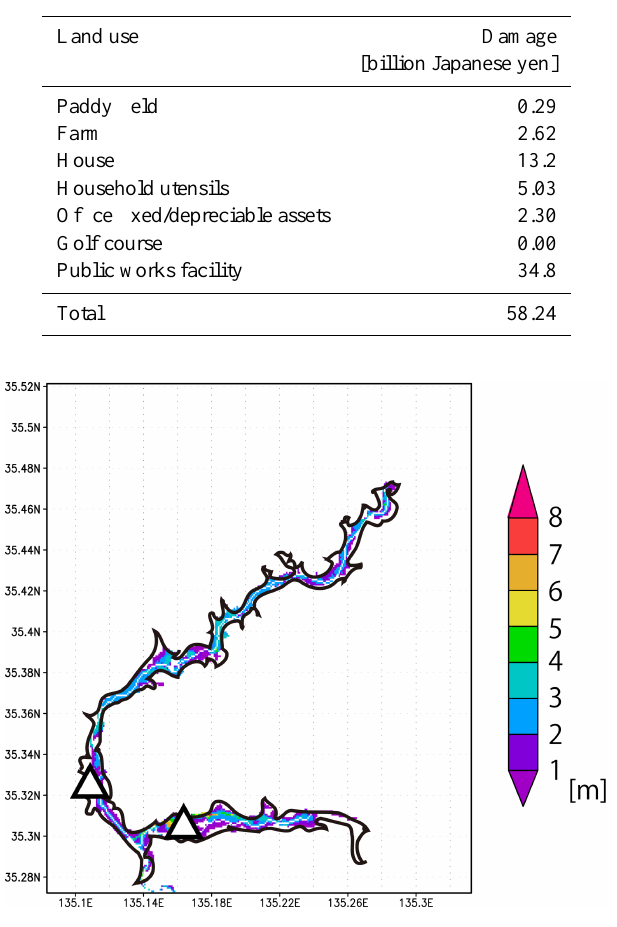
Figure 4. The investigated inundation area (the area surrounded by thick black lines) and the spatial distribution of the maximum water depth for the typhoon No. 18, 2013.